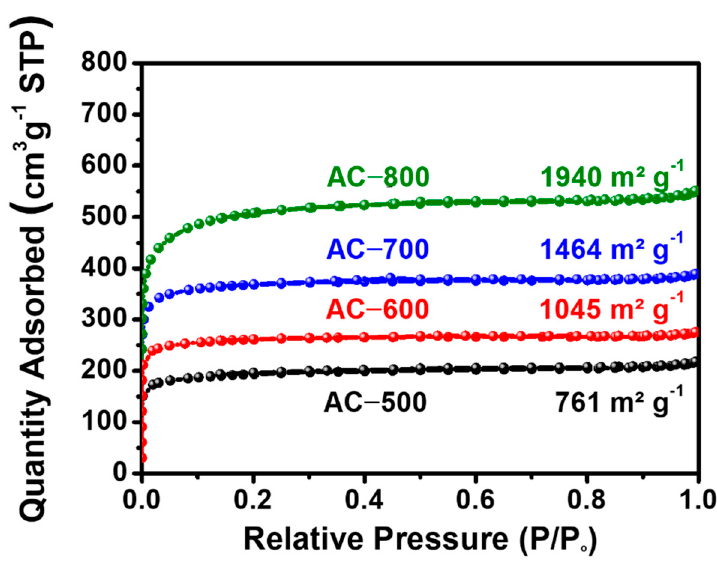
Figure 2. The N 2 isotherms of AC-500, AC-600, AC-700, and AC-800. Table 2. Comparison of specific surface areas and pore structures of the AC samples determined from the N 2 isotherms.